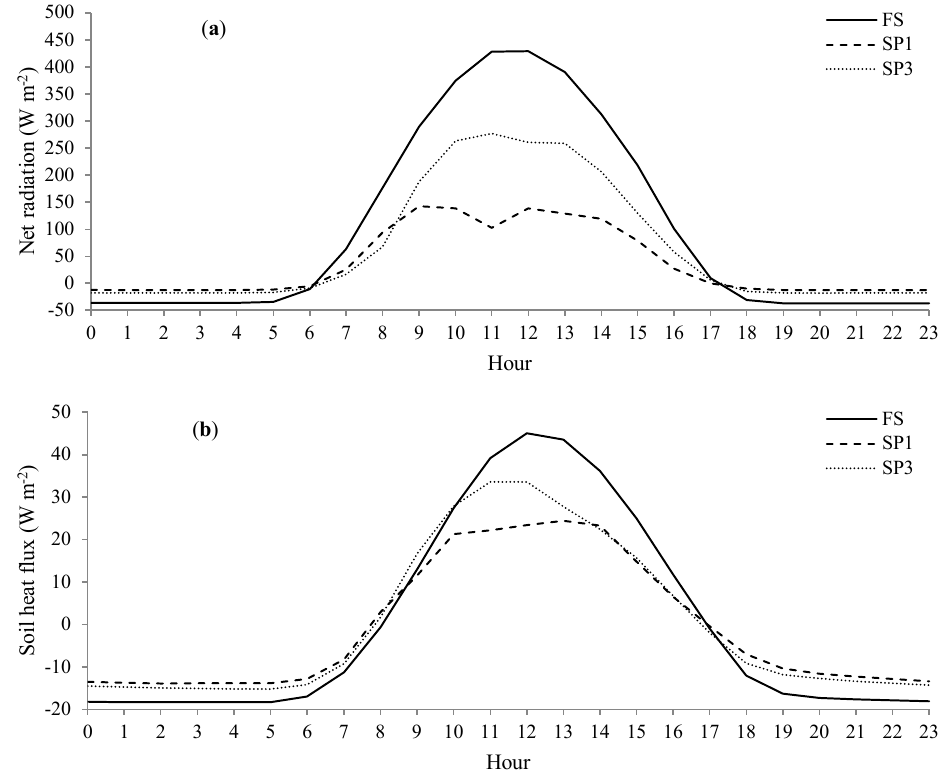
Figure 5. Average net radiation ( a ) and soil heat flux ( b ) at full sun (FS) and at two different positions within a silvopastoral system (SP1: 0.00 m and SP3: 7.50 m from the North